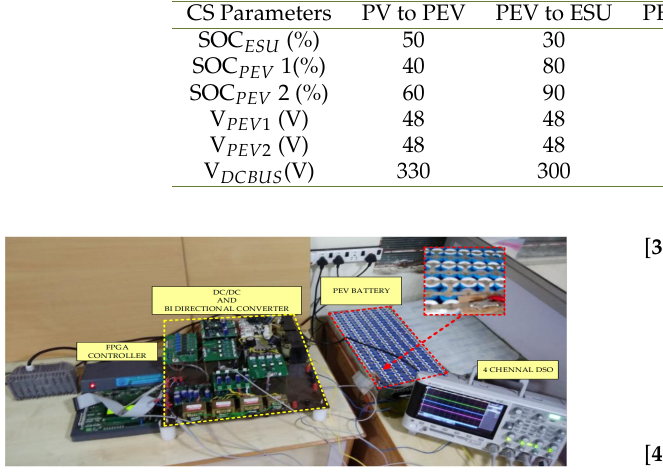
Table 1. Simulation results.